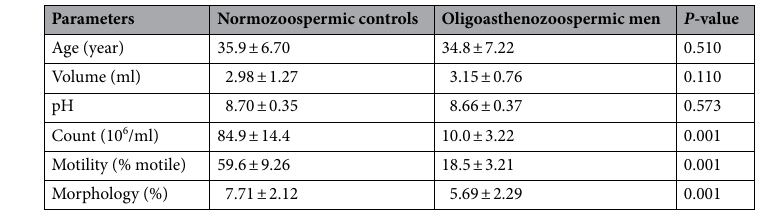
Table 1. Semen characteristics. Normozoospermic controls (n = 43) and oligoasthenozoospermic men (n = 44). An Unpaired two-tailed t-test was used to calculate the P -values. Data were presented as mean ± standard deviation. P < 0.05 was considered statistically